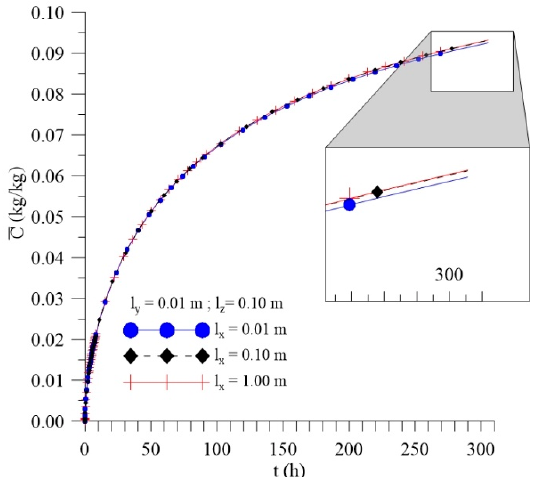
Figure 12. Kinetics of the average free solute concentration for different distances l x (Cases 8, 9, and 10).